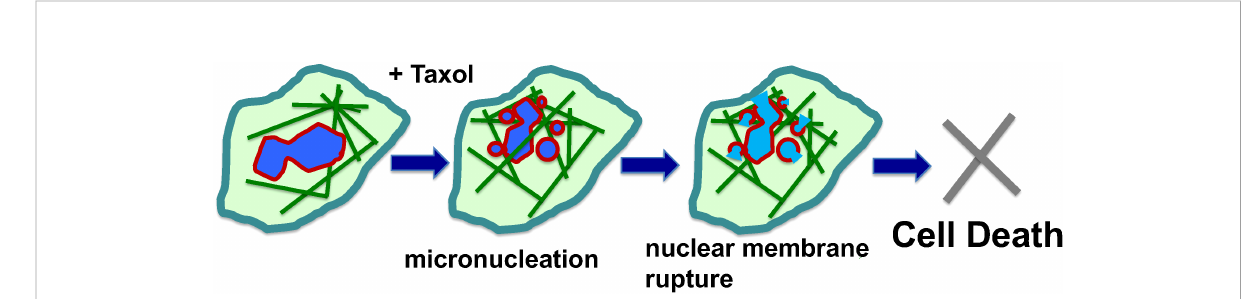
FIGURE 2 Mechanisms of paclitaxel-induced multiple micronucleation and nuclear membrane rupture in cancer killing. Paclitaxel (Taxol) induces mitotic catastrophe, resulting in micronucleation. In non-mitotic cells, the rigid microtubule fi laments induced by paclitaxel can promote massive formation of micronuclei through nuclear budding of cells during interphase. The paclitaxel-bound rigid microtubule bundles pull and distort the nuclear envelope structure. As a result, the malleable cancer nuclear envelope breaks into multiple micronuclei (micronucleation). The proposal of physical force exerted by paclitaxel-induced rigid microtubule fi laments in breaking malleable cancer nuclei provides a non-mitotic mechanism to generate multiple micronuclei. Paclitaxel also induces rigid microtubules and the breaking of nuclei of neoplastic cells and the formation of multiple micronuclei in both. The micronuclei derived from both mitotic and non-mitotic cells are defective in membrane structure and have high propensity for rupture and release of chromatin materials, resulting in cell